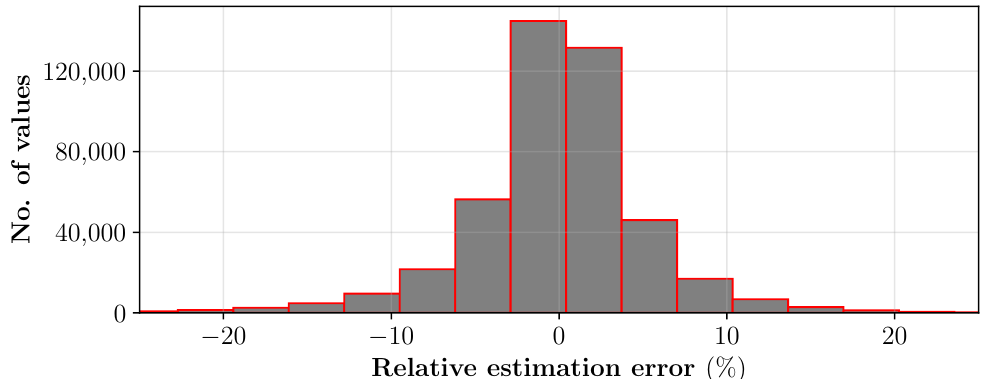
Figure 7. Top left : estimated pixel values of the e 0 r ( x , y ) for the test dataset with 1000 samples. Top right : histogram of factor κ . Bottom : difference between the estimated and true values (relative estimation error) of the real part of the dielectric constant for the total number of test samples.